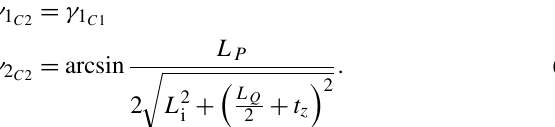
Figure 6. Incline plane schematic, with the (a) top view and (b) front